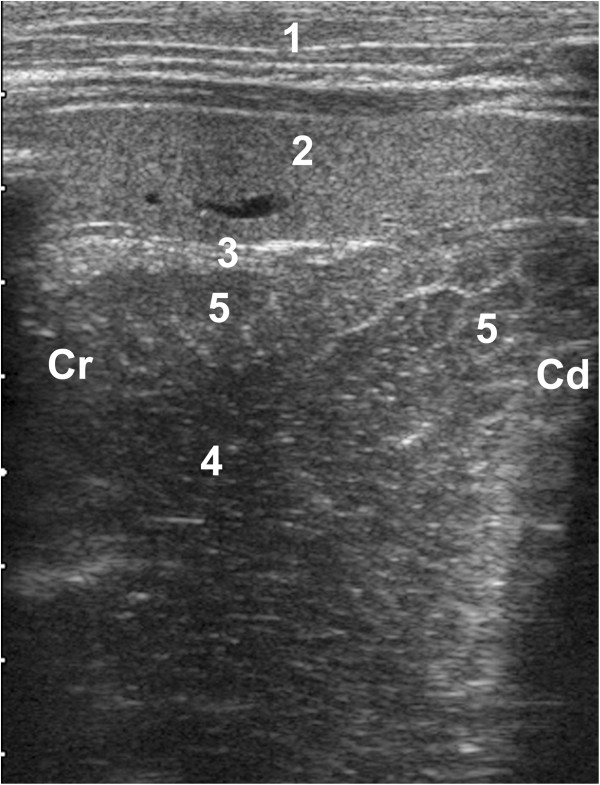
Ultrasonogram of the reticulum. Ultrasonogram of the reticulum of a 37-day-old Swiss Braunvieh calf with ruminal drinking syndrome. The 5.0-MHz linear transducer was held parallel to the sternum in the left lower thoracic area. The reticular content appears heterogeneous and echoic and the honeycomb-like structure of the mucosa can be seen. 1 Abdominal wall, 2 Spleen, 3 Reticular wall, 4 Reticular content, 5 Honeycomb-like structure of the mucosa, Cr Cranial, Cd Caudal.